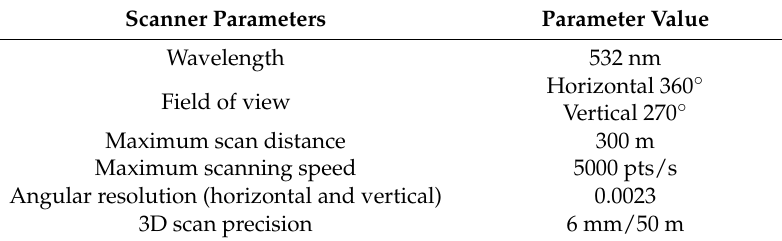
Table 3. Leica Scan Station parameter